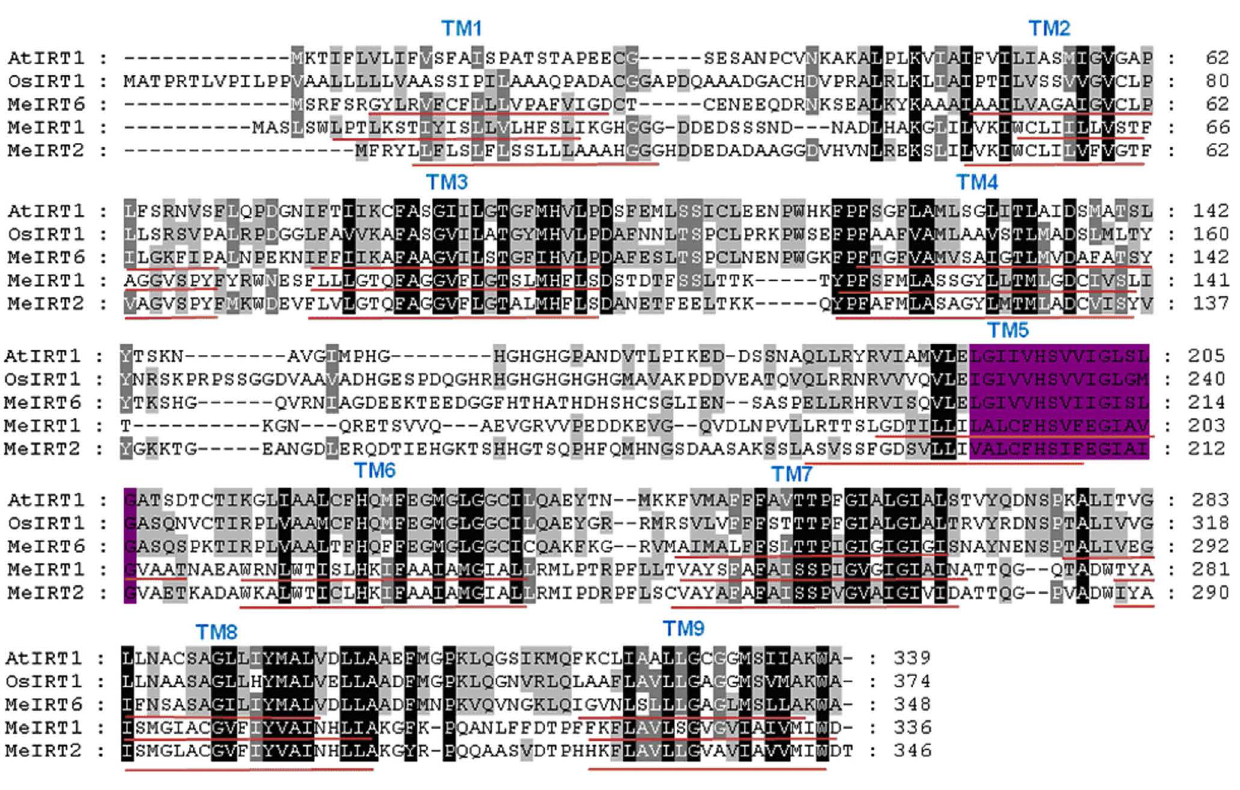
as red lines below the sequences.The highly conserved motif for ZIP proteins in the fifthTM is highlighted in purple. Species designations are as follows: At, A. thaliana (AtIRT1); Os, O. sativa (OsIRT1); Me, Mannihot esculenta (MeIRT1, MeIRT2, and